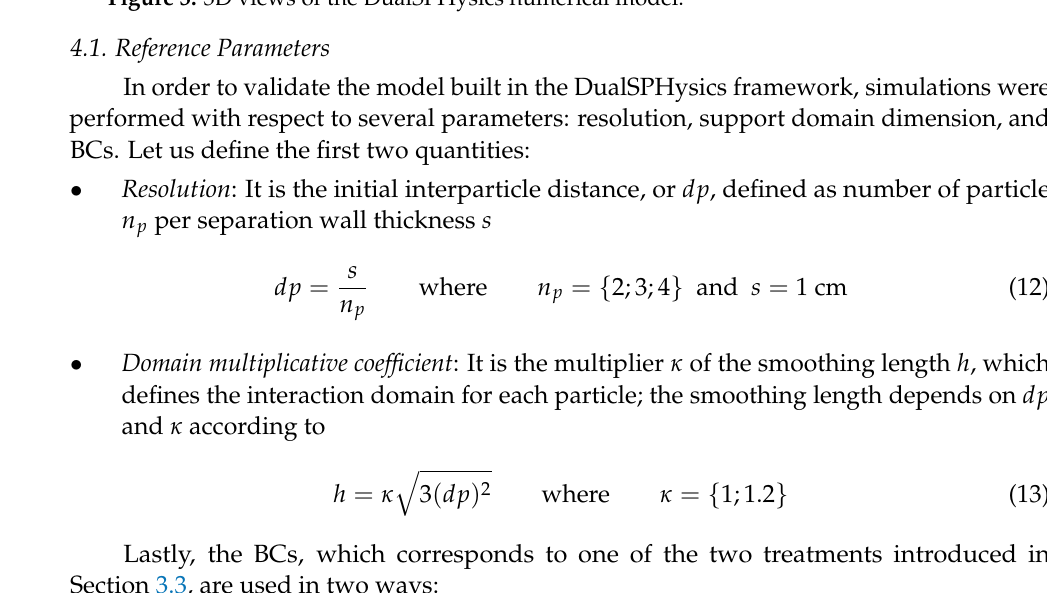
Figure 3. 3D views of the DualSPHysics numerical